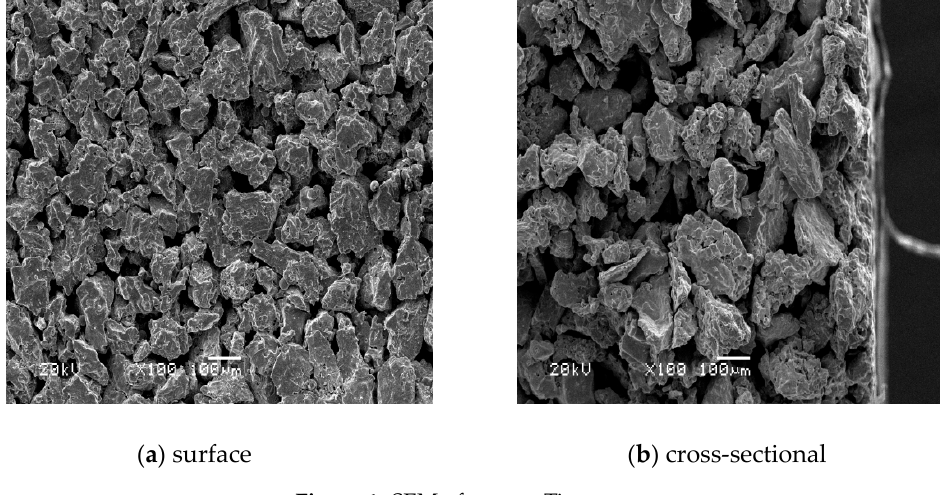
Figure 1. SEM of porous Ti support.